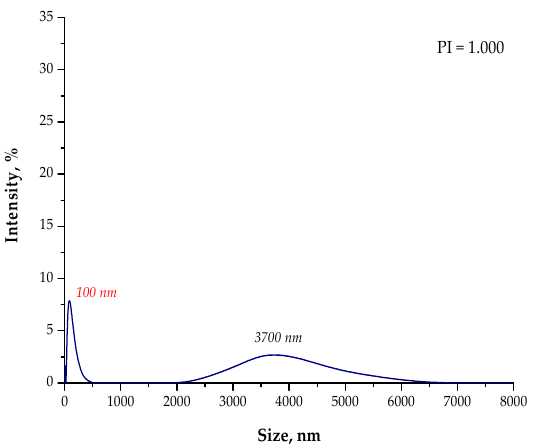
Figure 7. The size analysis of the Fe 3 O 4 @Ag particles obtained as a result of the synthesis performed using the 3% Arabic gum solution and the O/W reaction environment.